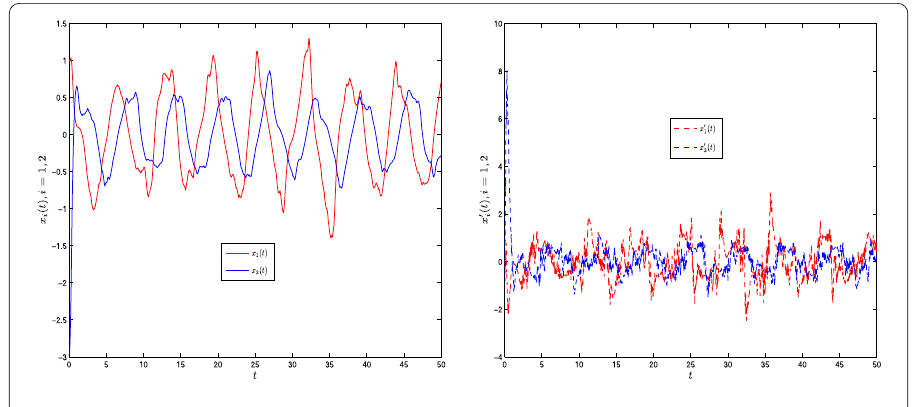
Figure 1 The states and their first-order derivatives of (3.1) with initial values ( x 1 ( s ), x 2 ( s ), x (cid:2) 1 ( s ), x (cid:2) 2 ( s )) = (1,–3,0,0), s ∈